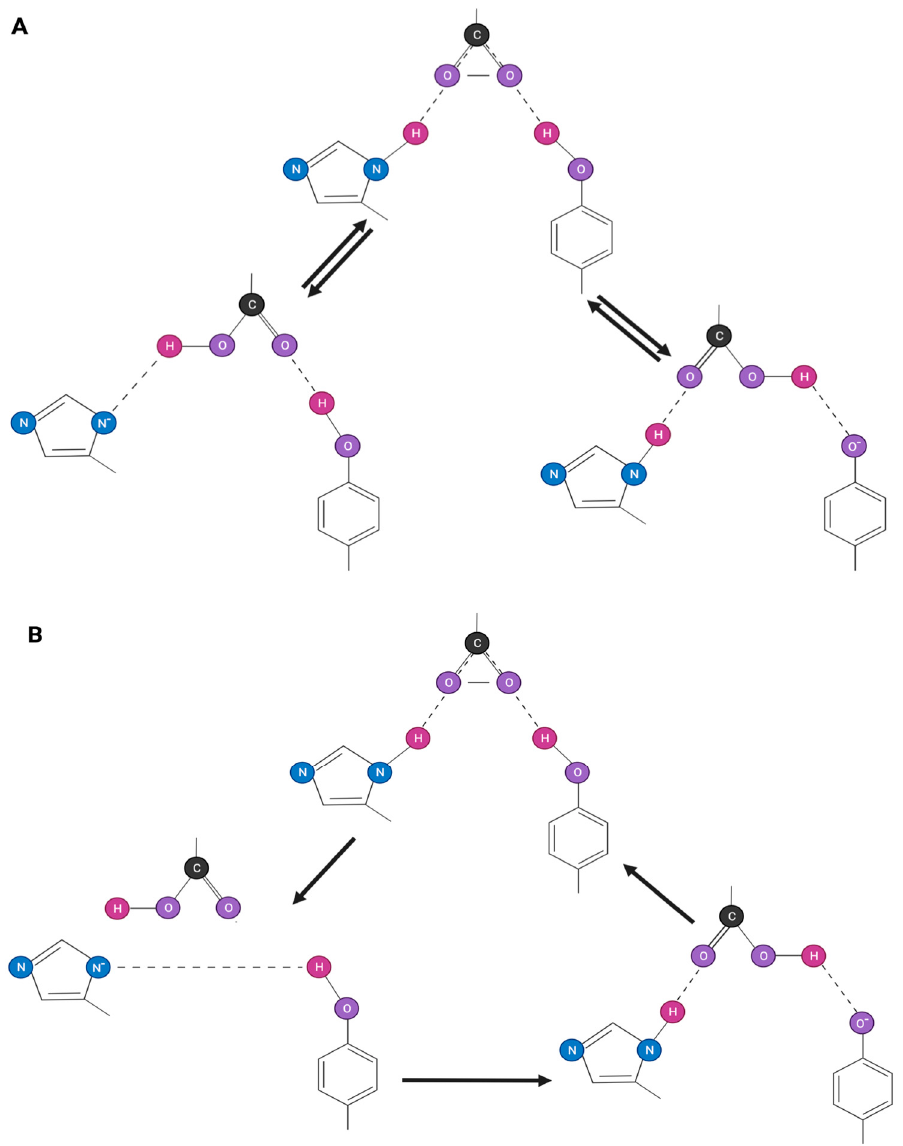
Figure 2. Angiotensin II charge relay system showing the movement of charge from carboxylate to tyrosinate. ( A ) “Swing” mechanism in which the C-terminal carboxylate group on angiotensin abstracts a proton directly from either the imidazole of His 6 or the hydroxyl of Tyr 4 . ( B ) “Roundabout” or charge relay mechanism in which the C-terminal carboxylate group of angiotensin abstracts proton from the imidazole of His 6 , which, in turn, abstracts the hydroxyl proton of Tyr 4 .